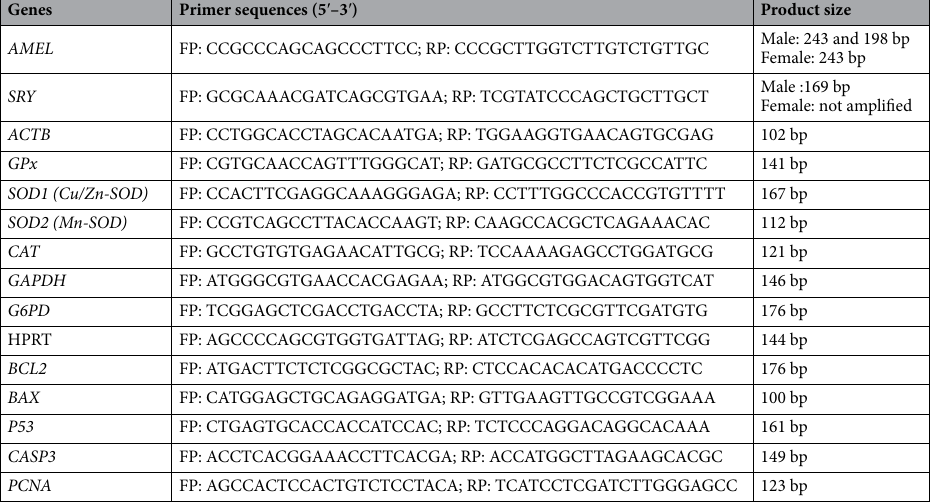
Table 3. Primers used for sex determination of embryos and gene expression